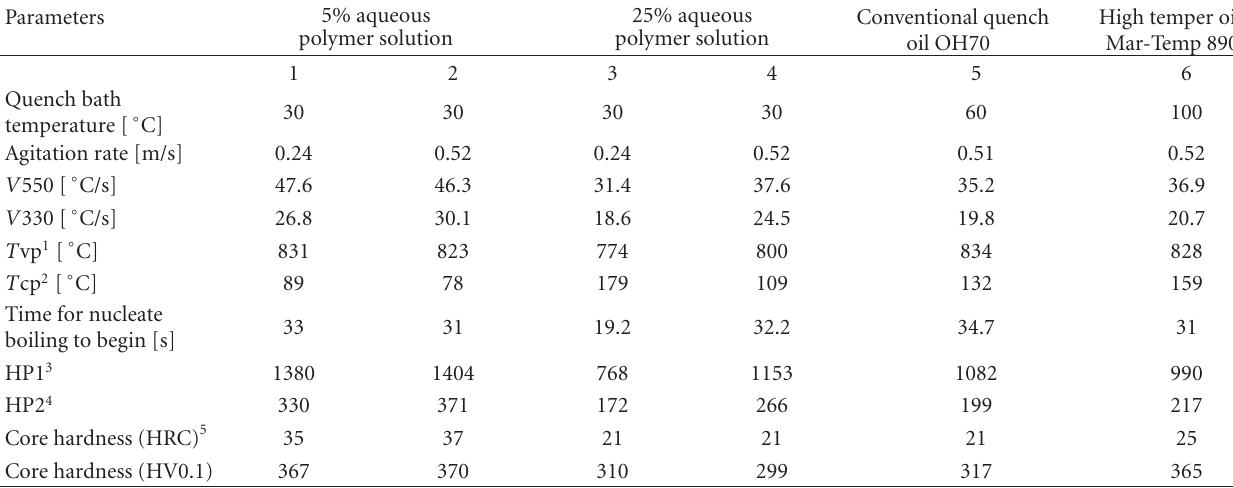
Table 3: Summary of quenchants and quenching